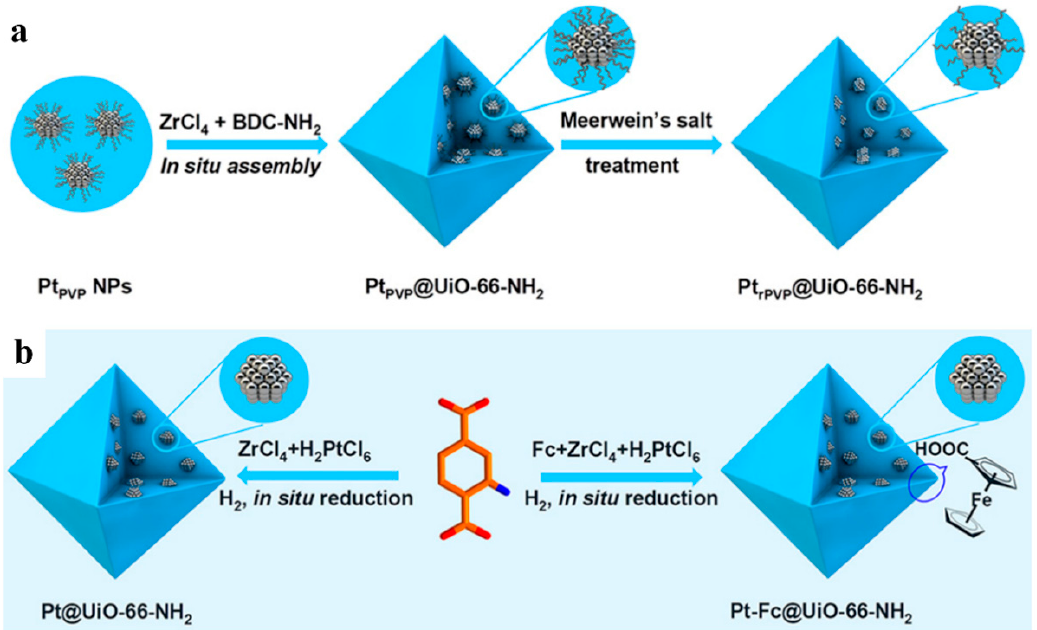
Figure 7. The schematic diagram of synthesis steps for various photocatalysts. ( a ) Pt PVP @UiO-66-NH 2 and Pt rPVP @UiO-66-NH 2 ; ( b ) Pt@UiO-66-NH 2 and Pt-Fc@UiO-66-NH 2 . Reproduced with permission from Ref. [70].